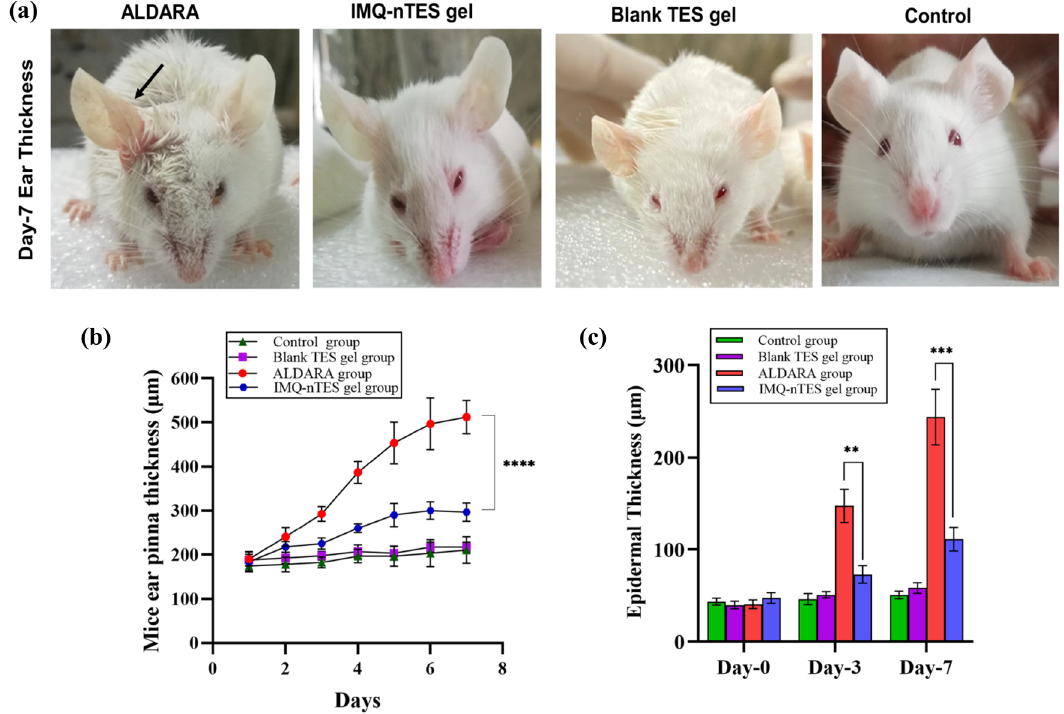
Figure 6. ( a ) Right ear pinnae enlargement (day-7) observed in all experimental groups (no enlargement was observed in Blank TES gel, IMQ-nTES gel and control group). ( b ) Mice right ear pinnae thickness observed in all groups. ( c ) Cutaneous epidermal thickness (in μm) of all experimental groups. All the data is presented as mean ± S.D, n = 3; *p < 0.05, **p < 0.01, ***p < 0.001, ns p > 0.05.